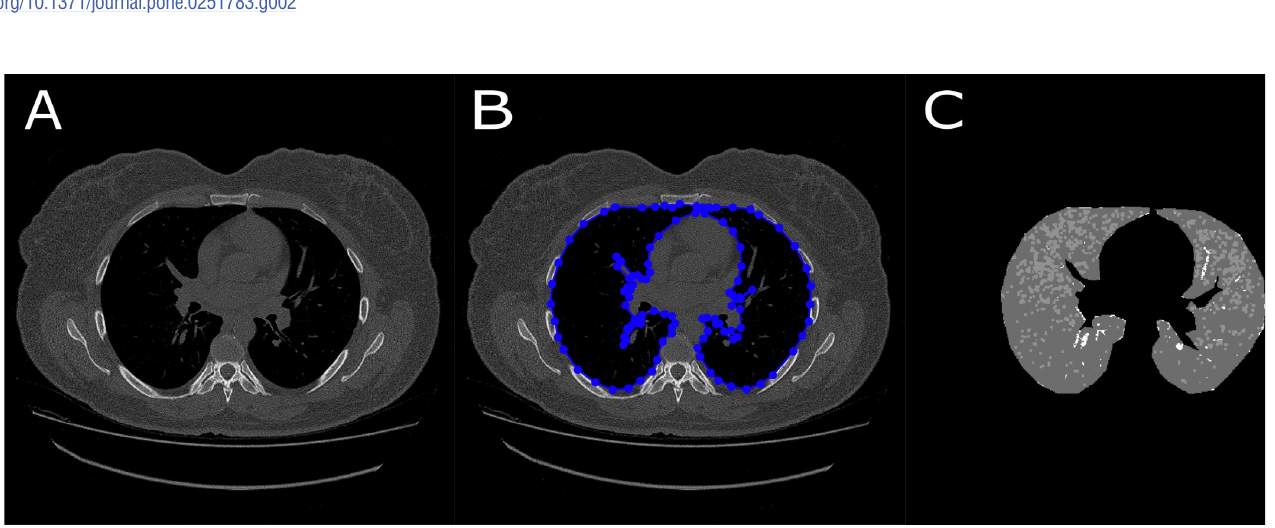
Fig 3. Sequence of images that demonstrate the semi-automatic algorithm steps. A–Original image; B–Segmentation performed by an experienced radiologist. All blue lines and dots represent the manual segmentation of lung boundaries. C–Final segmentation.